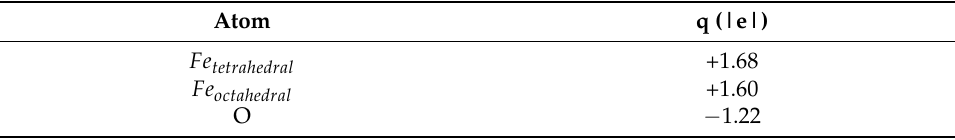
Table 1. Units for magnetic